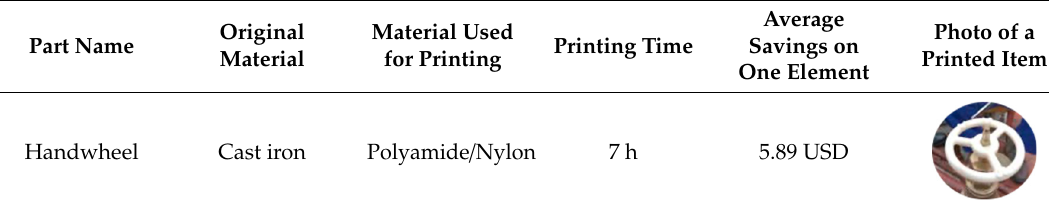
Table 4. Examples of 3D printed elements, production times and savings [43].